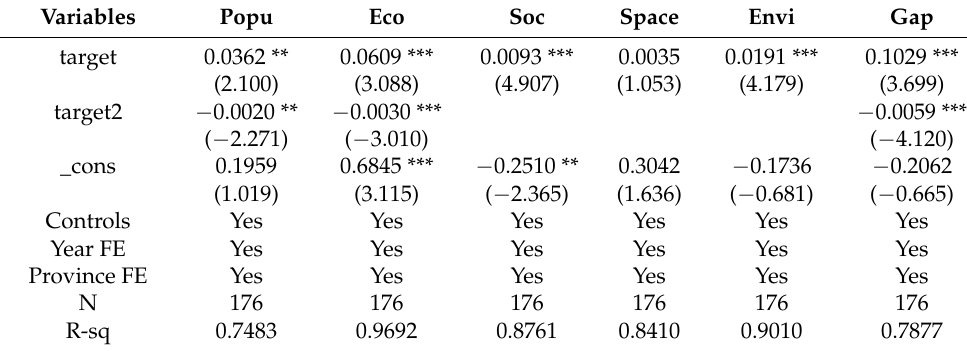
Table 8. Path analysis of the eastern region.